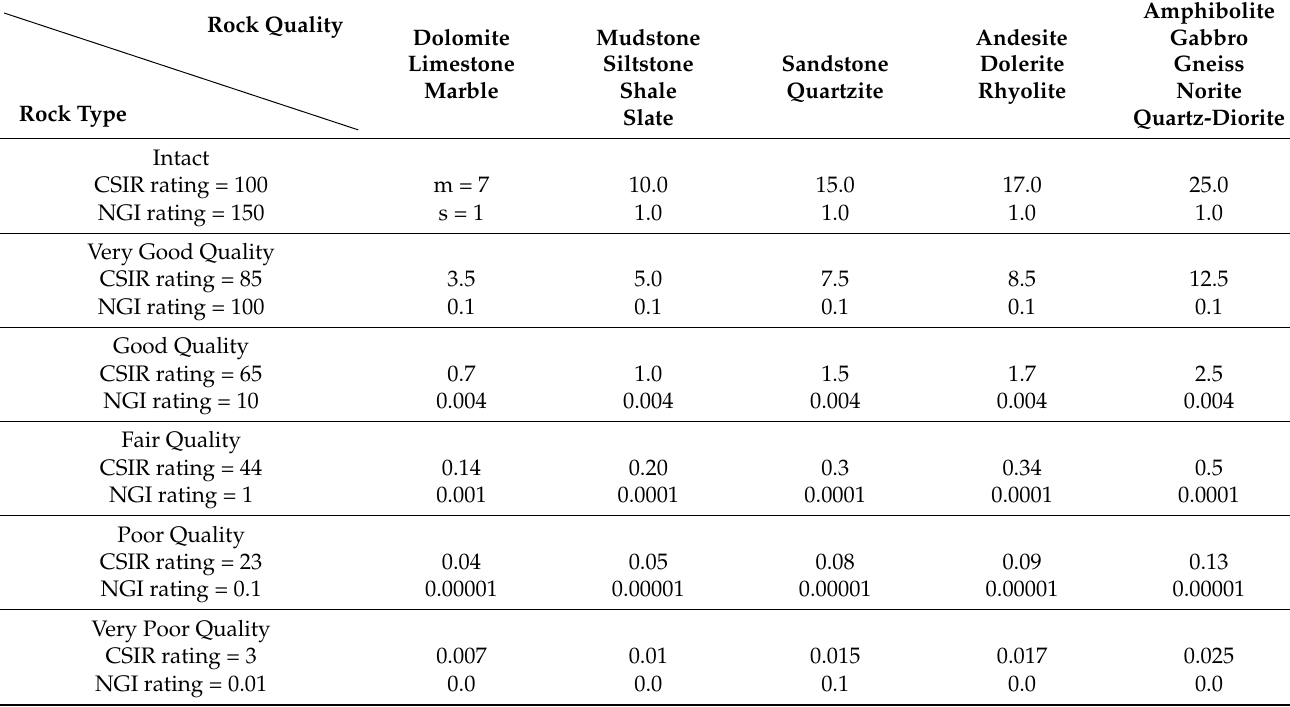
Table A1. Hoek and Brown Material Parameters (m,